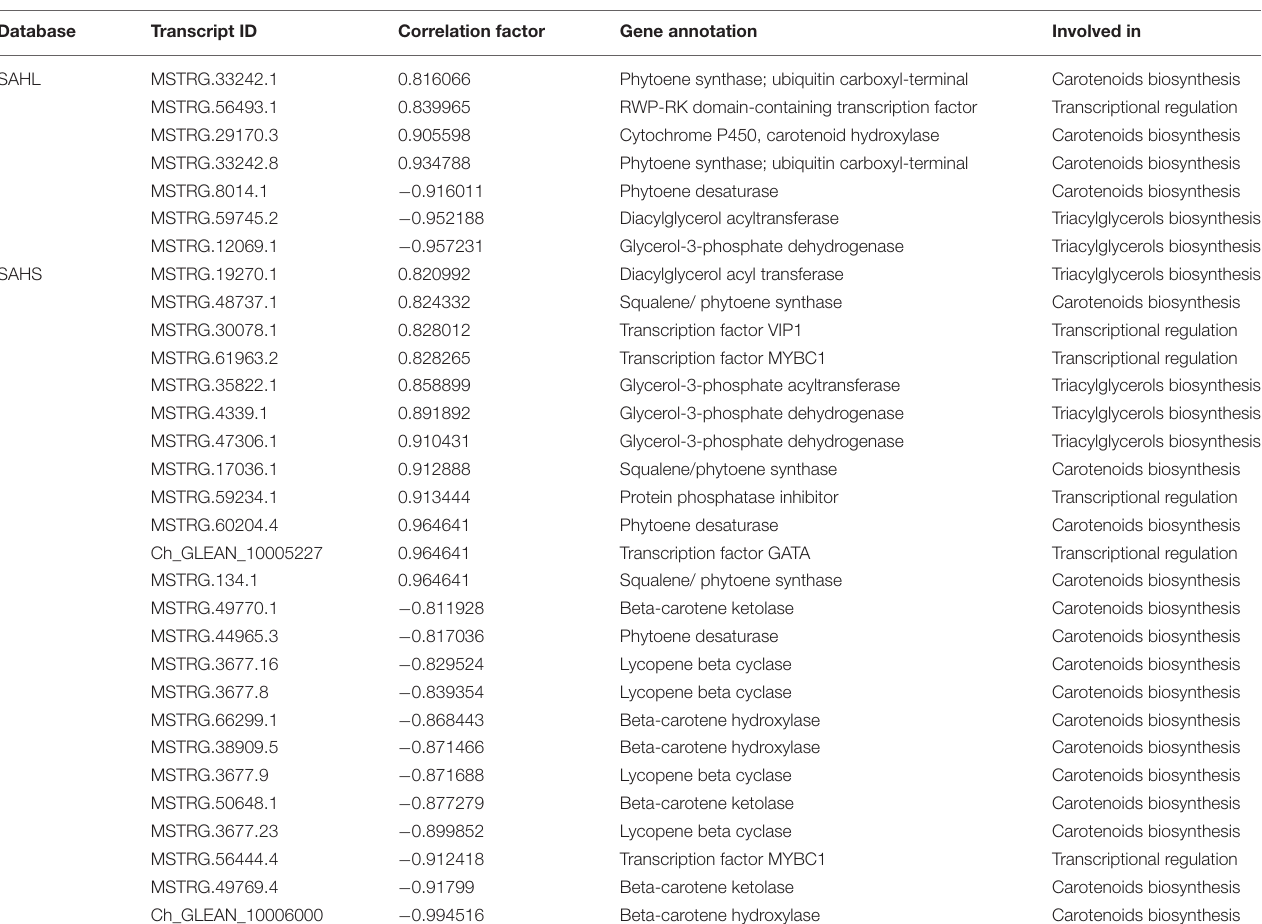
TABLE 2 | The annotation of transcripts presented in the correlation network constructed using transcriptome data of SAHL and SAHS,